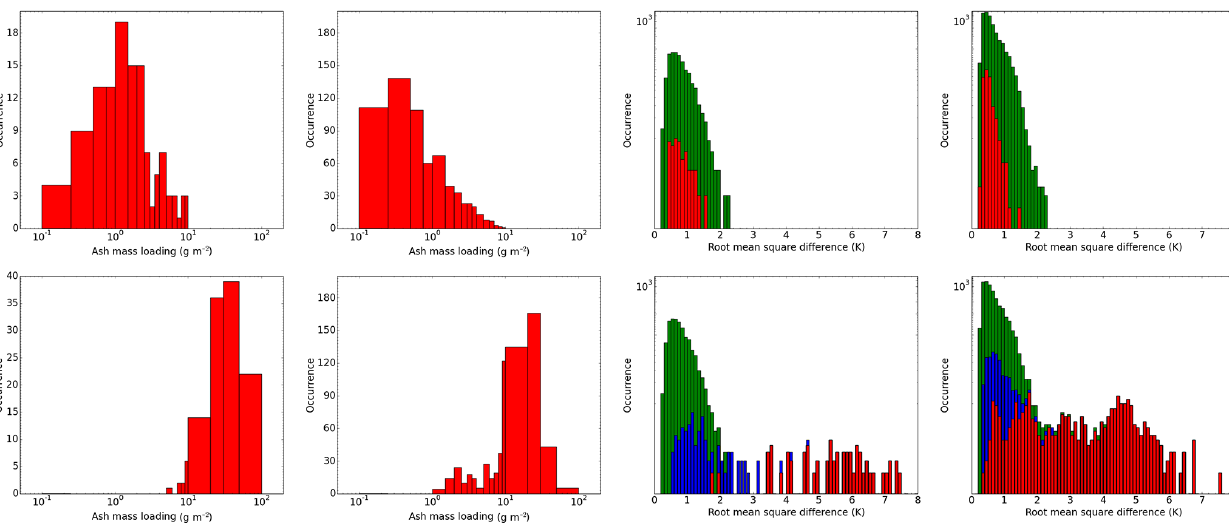
Figure 10. (Upper row) The frequency of the ash mass loading (columns 1 and 2) and the RMSD (columns 3 and 4) when including all types of simulated spectra. (Lower row) The frequency of the ash mass loading (columns 1 and 2) and the RMSD (columns 3 and 4) when not including spectra with both ash and ice. In columns 3 and 4, the red bars represents ash-affected pixels while the green bars are all other pixels. The blue bars represents the ash-affected pixels but modelled ice spectra were used to calculate the RMSD, see text for details. Note log-scale on y axis for panels in columns 3 and 4. Columns 1 and 3: data from 14 February 2014. Columns 2 and 4: data from 15 February